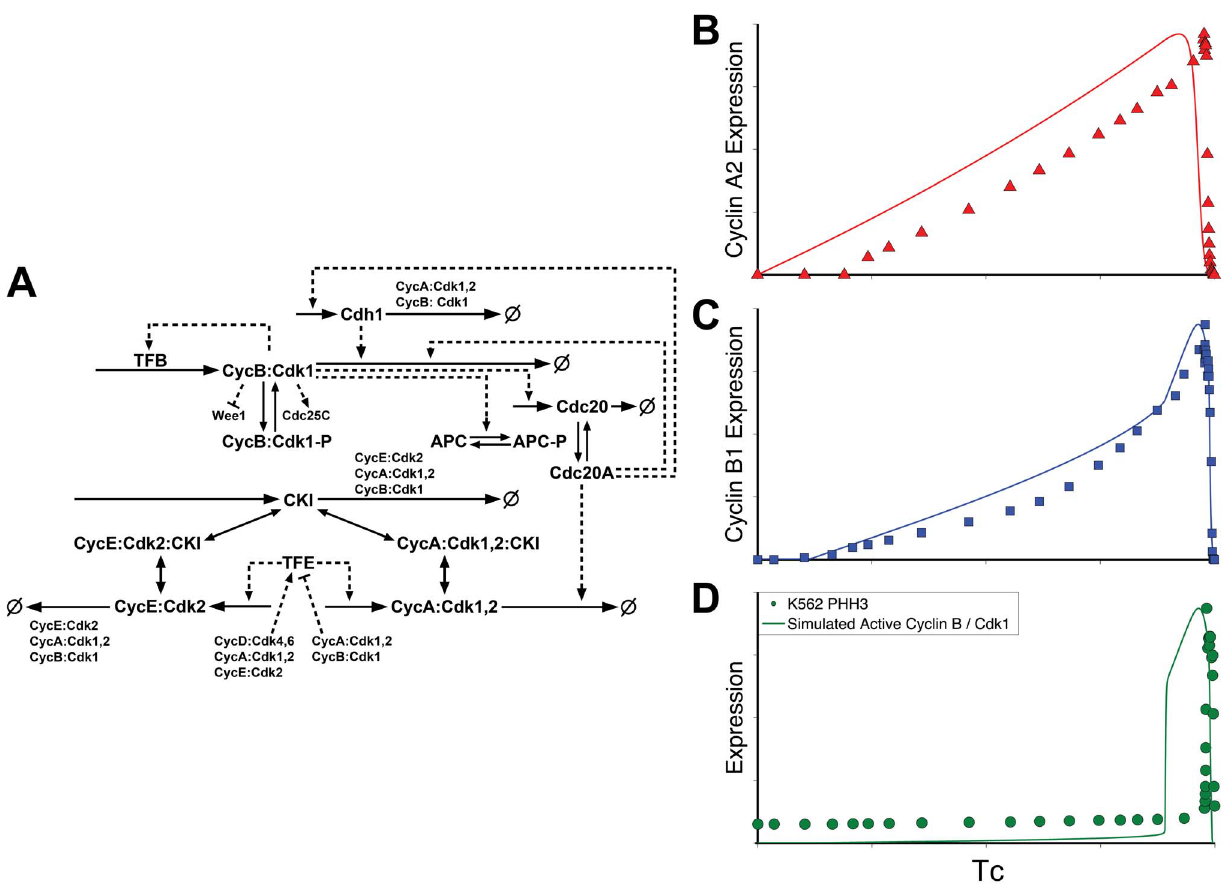
Figure 3. Model Schematic and comparison of model outputs to expression data II. A : Schematic derived from the Csikasz-Nagy model [26]. Solid and dashed line representations are as in Figure 2. B, C, D : normalized comparison of model outputs (simulated total protein levels (as in Figure 2) of cyclin A and cyclin B, and cyclin B/Cdk1 activity) to K562 expression data. Simulations were carried out using the published protocols and kinetic rate constants.